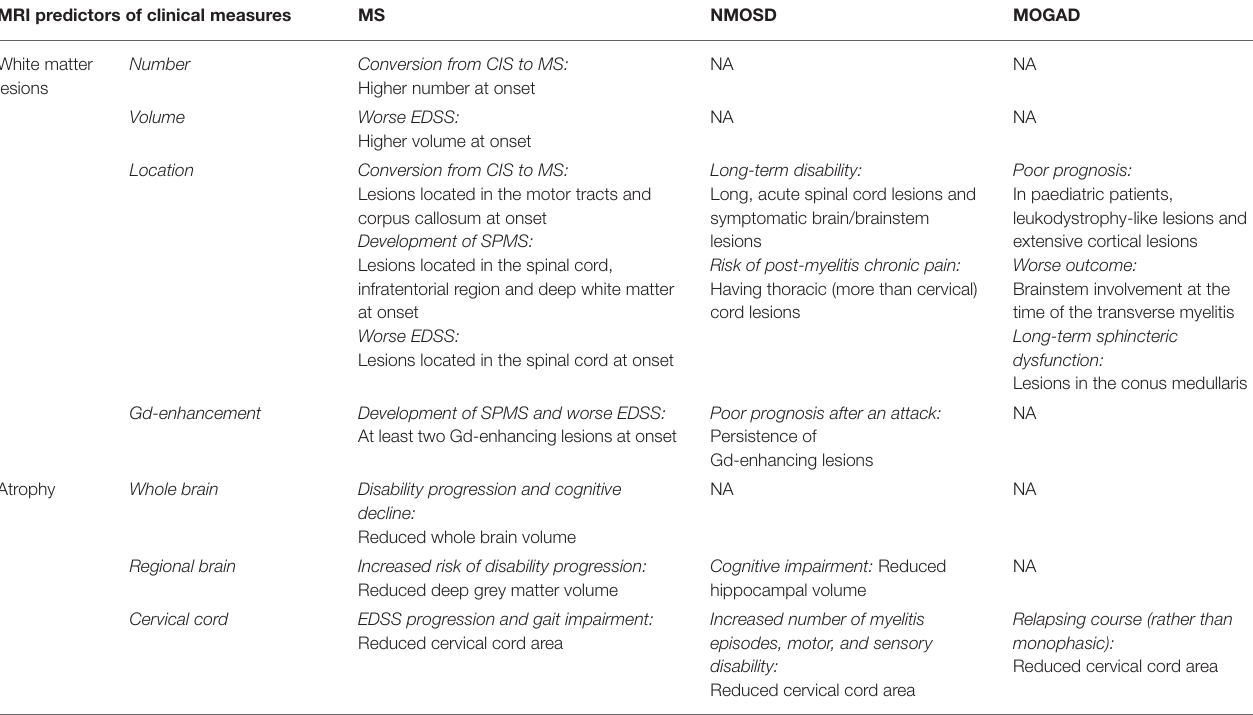
TABLE 1 | Conventional MRI measures with an established prognostic role on clinical disability in multiple sclerosis (MS), neuromyelitis optica spectrum disorder (NMOSD), and myelin oligodendrocyte antibody disease (MOGAD). MRI predictors of clinical